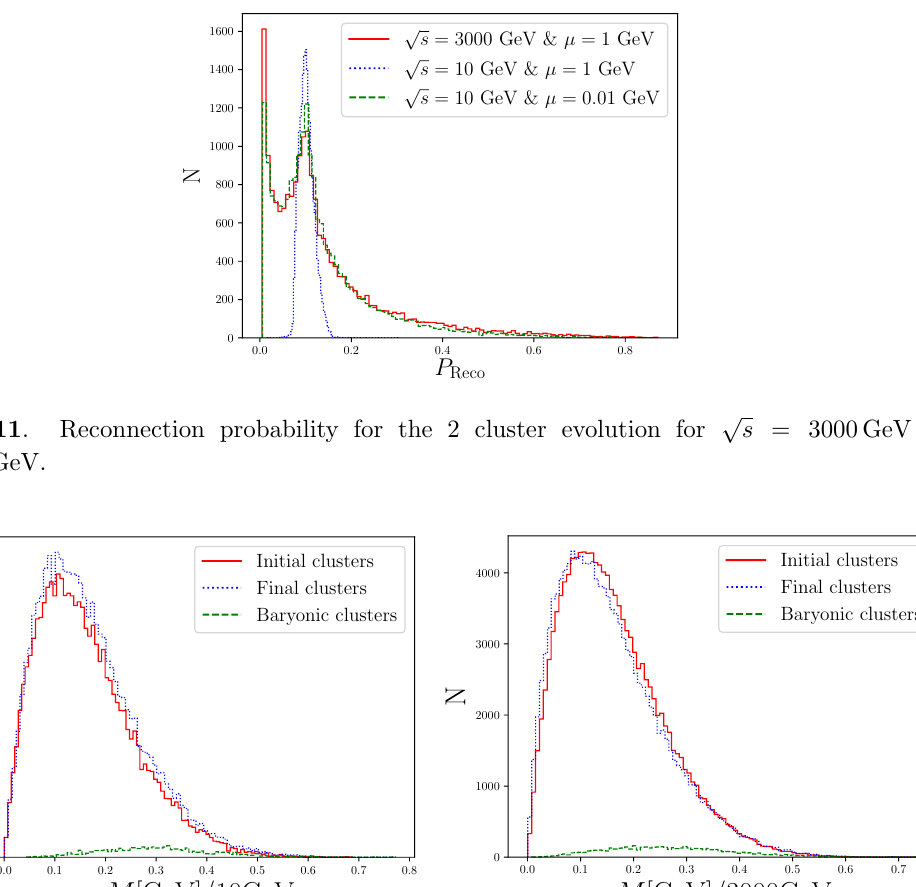
p s = 3000 GeV divided